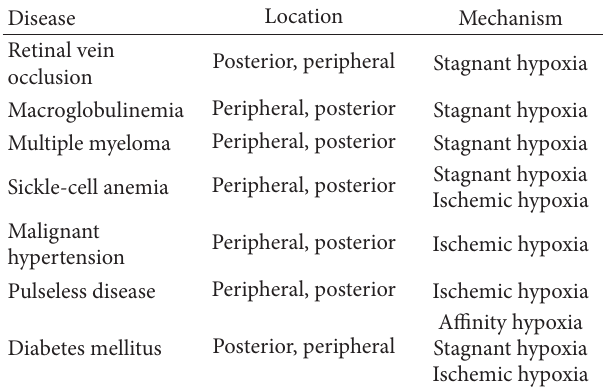
Table 1: Capillary retinal microaneurysms are found in the follow- ing diseases, all associated with some form of